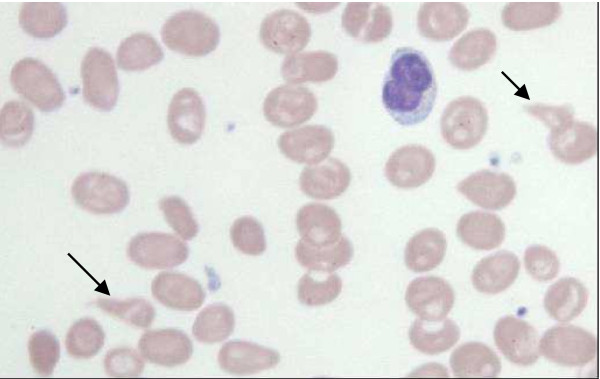
Peripheral blood smear (May-Grünwald Giemsa stain), 500×. Macro-ovalocytes. Schistocytes (arrows).